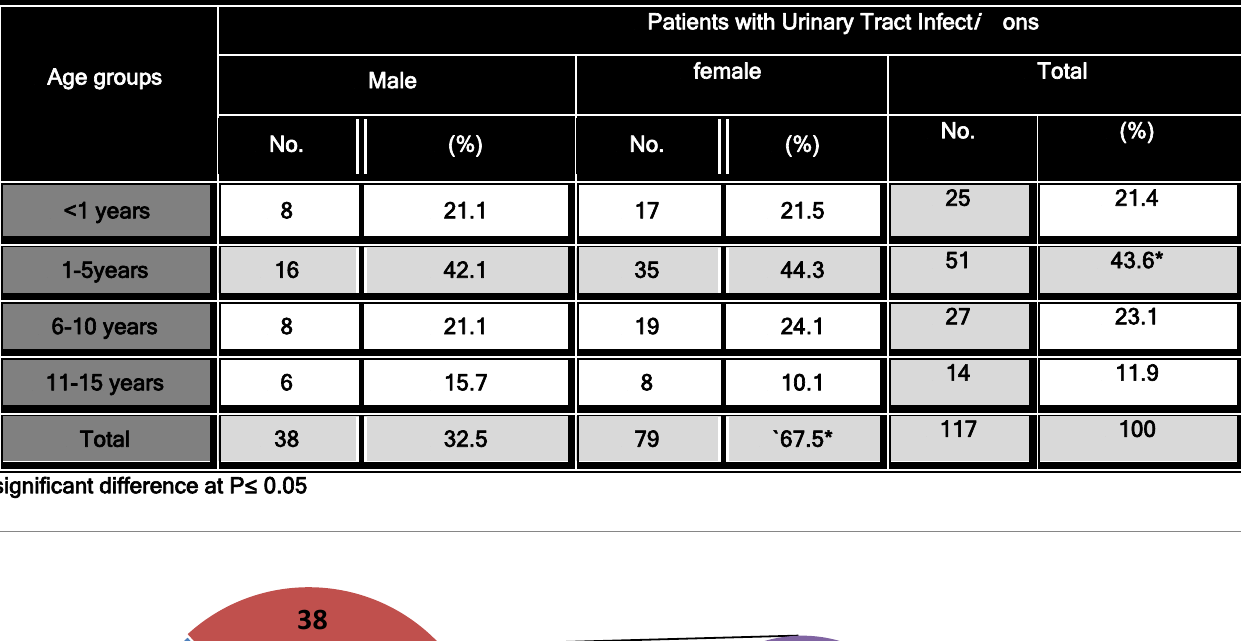
Table- 1: Distribution of Urinary Tract Infections according to age and sex.